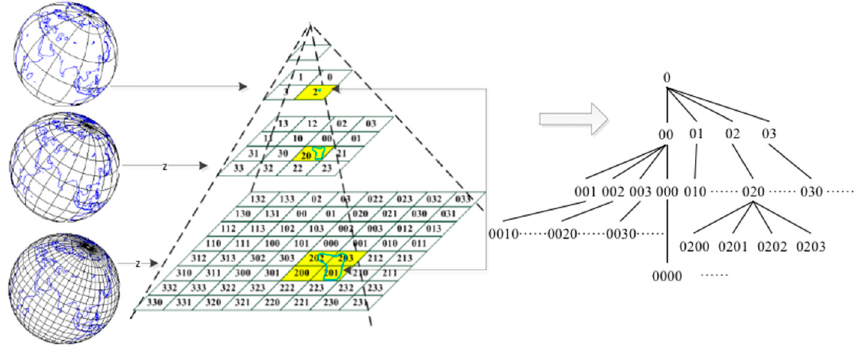
Figure 1. The GeoSOT subdivision and encoding procedure. Each grid cell of each level is encoded by a geographical code according to the Z-order filling curve [32]. The code exhibits the following characteristics: (1) Uniqueness: Each grid cell has a globally unique code corresponding to a rectangle on the Earth’s surface. (2) One-dimensional: GeoSOT uses a one-dimensional number or binary bit string to represent a region of two-dimensional